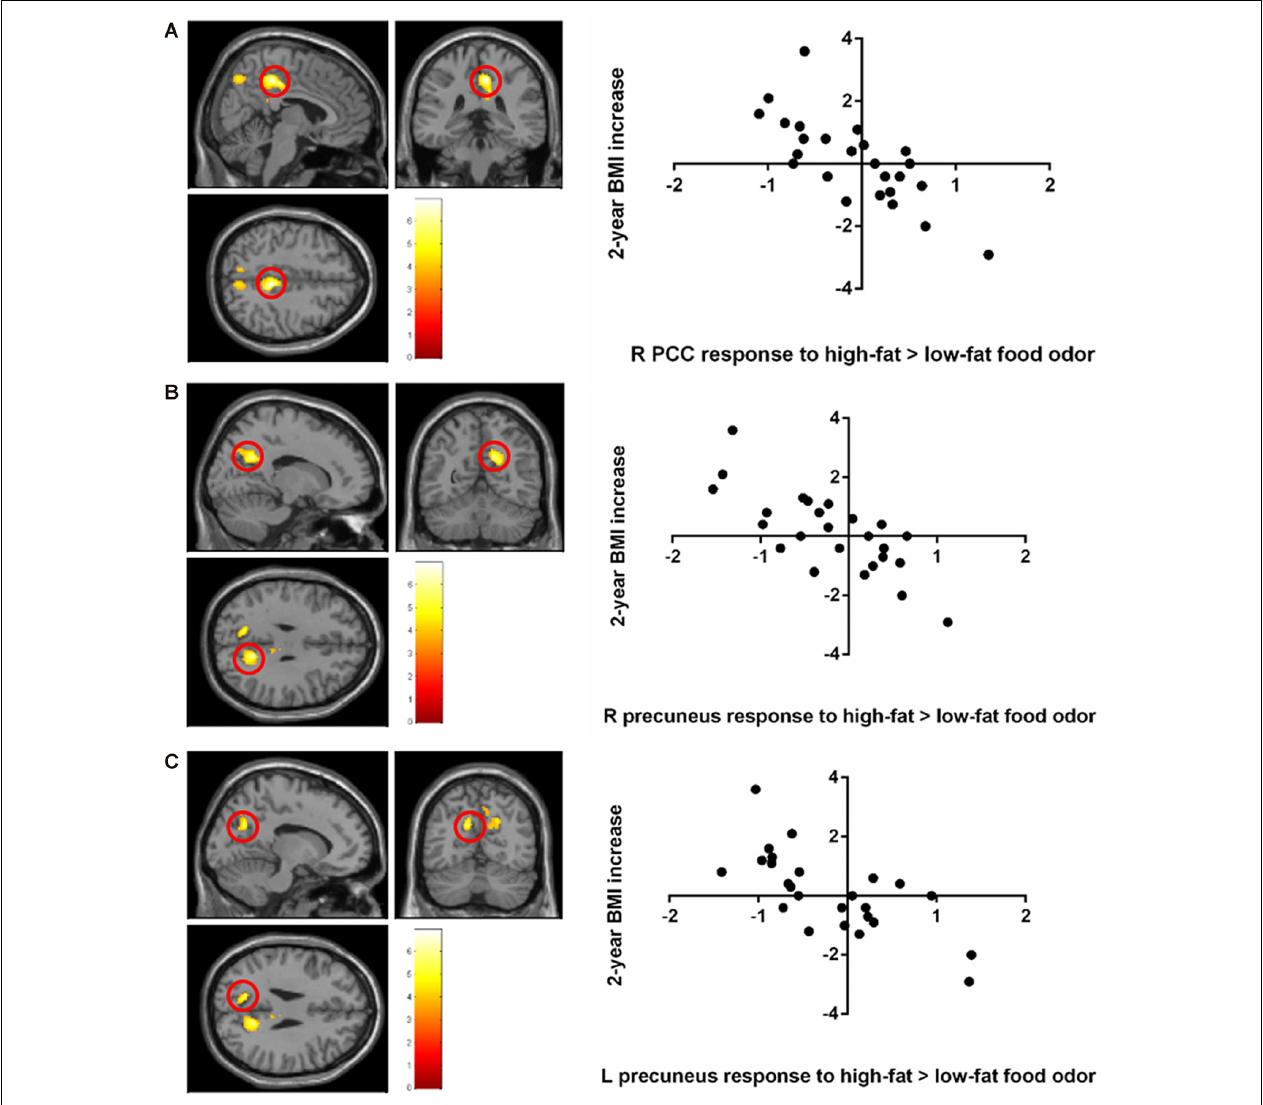
FIGURE 2 | Negative correlation between the 2-year body mass index (BMI) increase and baseline brain responses to high-fat vs. low-fat food odors in (A) the posterior cingulate cortex (PCC), (B) the left precuneus, and (C) the right precuneus. Brain activation was significant with corrected p < 0.05 and was illustrated on a template provided in SPM12